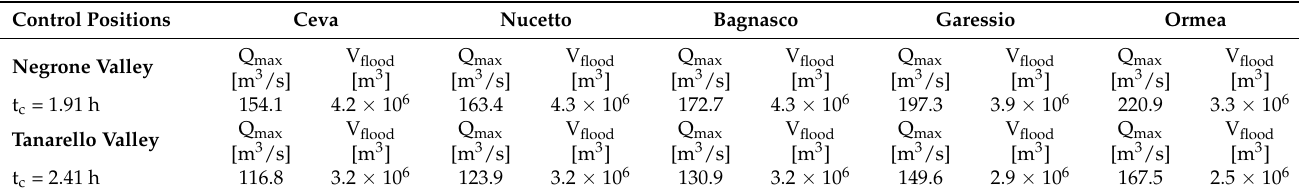
Table 5. Evaluation of the maximum expected flood volume at the dam located along the Negrone River and the Tanarello River, obtained using the rainfall intensity values calculated at each of the five control positions along the Tanaro River.